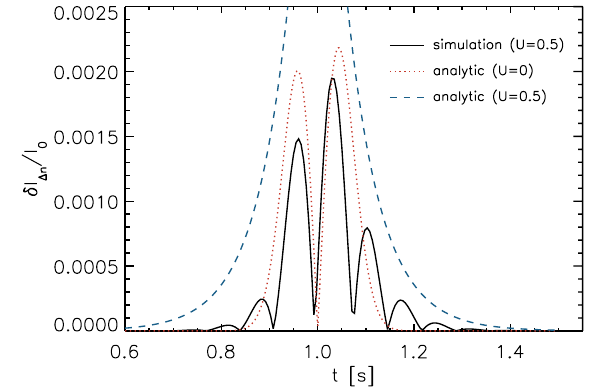
FIG. 3. (Color) Comparison of the echo amplitude versus time obtained from the simulation (solid line), the analytic ballistic echo theory (red dotted line), and from the analytic collective echo theory (blue dashed line) for U (cid:2) 1 : 5 and (cid:6) (cid:2) 0 : 1 s .